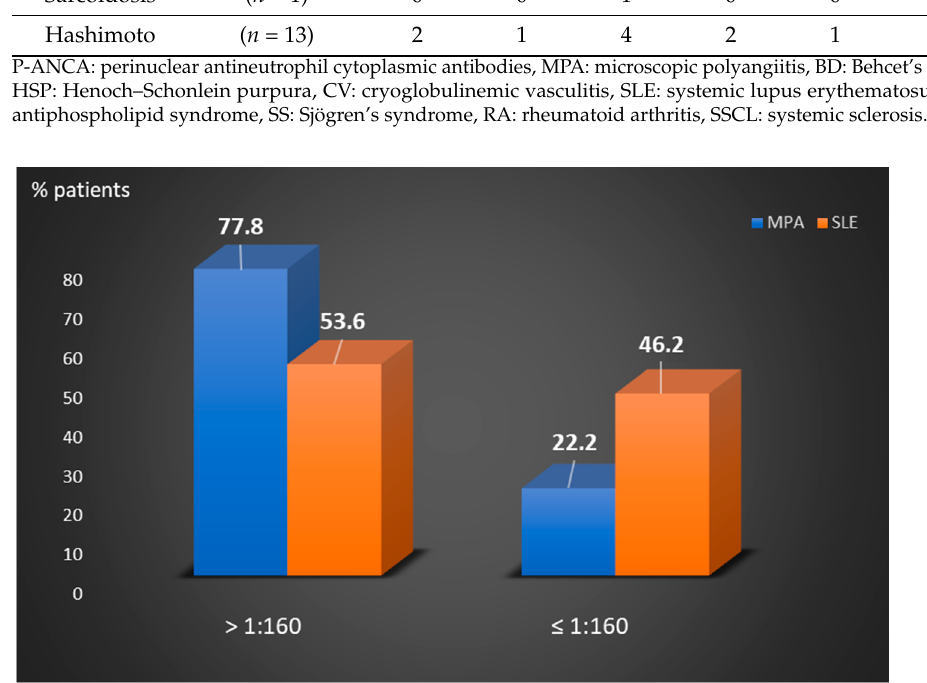
Figure 1. Comparison of the percentages of P-ANCA-positive MPA and SLE patients according to low ≤ 1/160 or high >1/160 titers. MPA: microscopic polyangiitis, SLE: systemic lupus erythematosus.